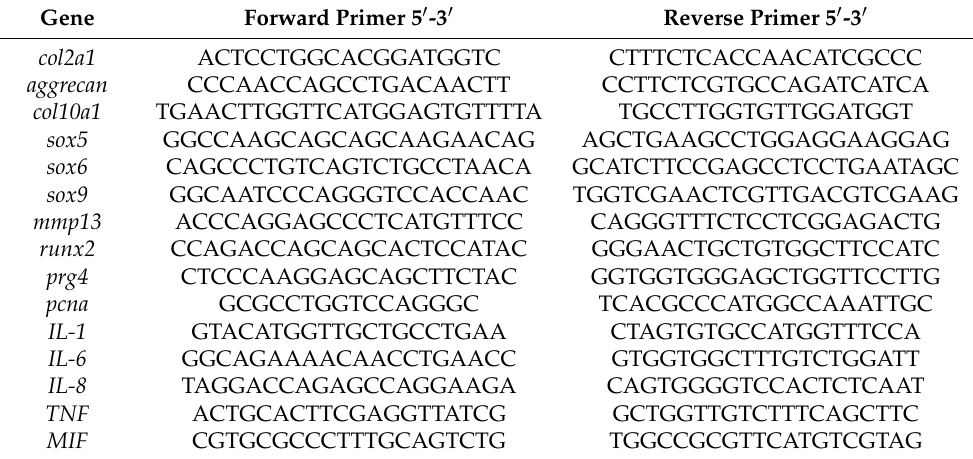
Table 1. Primer used in the present